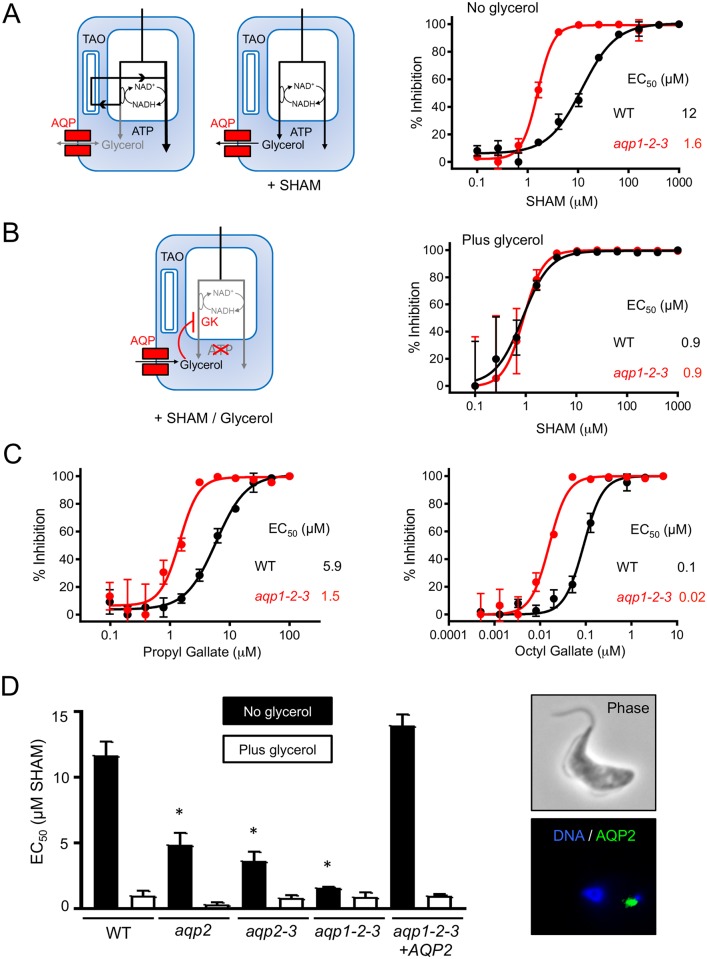
aqp-null T. b. brucei display defective glycerol-efflux and respiratory inhibitor-sensitivity.(A) Bloodstream T. brucei express a SHAM-sensitive mitochondrial trypanosome alternative oxidase (TAO). Under aerobic conditions, TAO activity allows ATP production without glycerol production as indicated by the black lines (left-hand blue ‘cell’). SHAM blocks TAO-activity, leading to the anaerobic production of glycerol, which is toxic if not removed, as indicated by the black lines (right-hand blue ‘cell’). SHAM dose-response curves for wild-type (WT) and aqp1-2-3 null-cells. EC50 values are indicated. (B) In the presence of SHAM and glycerol, the glycerol inhibits glycerol kinase (GK), also preventing ATP-production by the anaerobic route (blue ‘cell’). SHAM dose-response curves as in A but in the presence of 10 mM glycerol. (C) Propyl gallate and octyl gallate dose-response curves for wild-type (WT) and aqp1-2-3 null-cells. EC50 values are indicated. (D) SHAM EC50 values +/- 10 mM glycerol from A-B and also from aqp2, aqp2-3 and aqp1-2-3 cells re-expressing GFPAQP2. * indicates significantly different (P<0.01) to WT using an ANOVA test in GraphPad Prism. Pairwise comparisons +/- glycerol, except in the case of the aqp1-2-3 null, indicated significant (P <0.001) differences using a Student’s t-test. Error bars, SD. The images to the right show re-expression of GFPAQP2 in aqp1-2-3 null-cells.